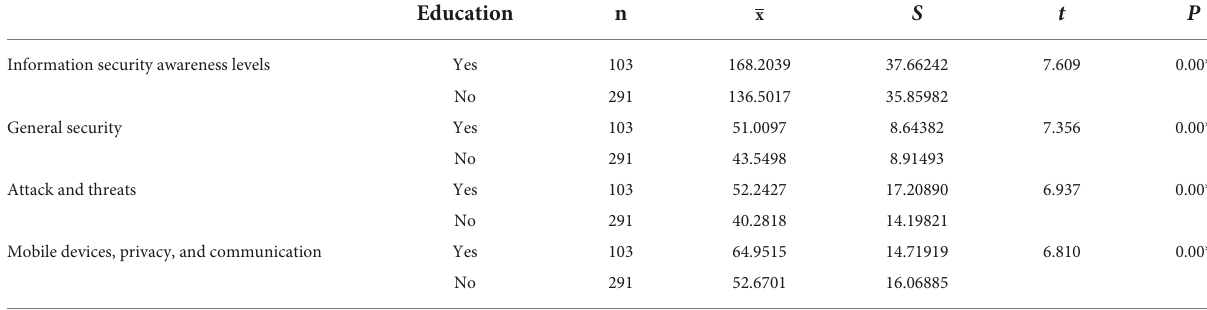
TABLE 4 Teachers’ information security awareness levels and sub-factors relations by receiving education on information